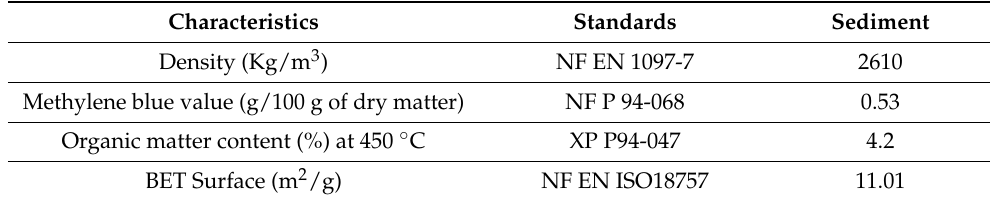
Table 2. Physical characterization of the sediment.